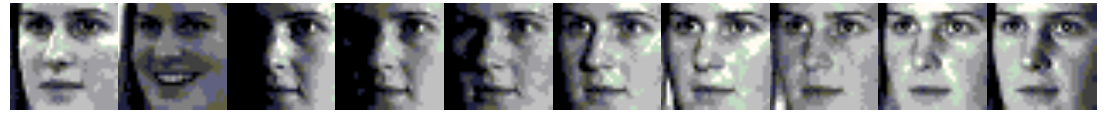
Figure 5. Sample face images of the CMU PIE face database.